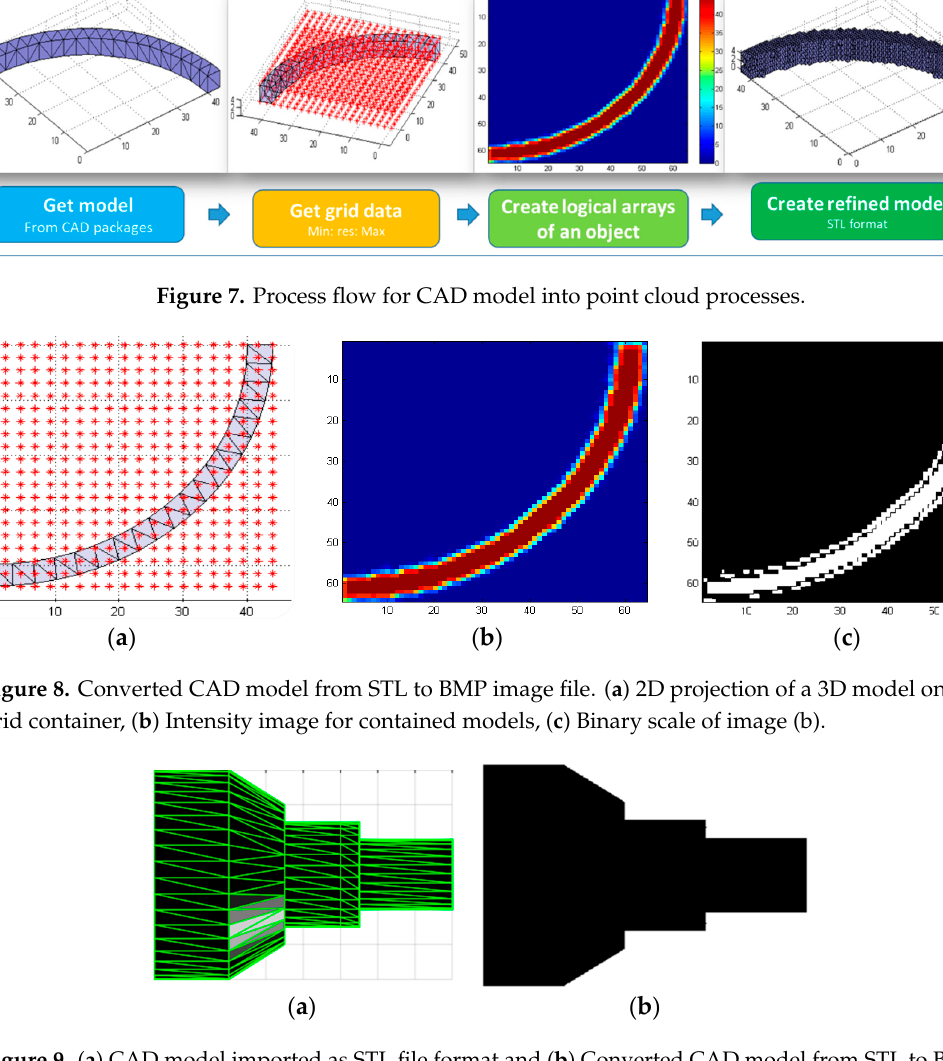
Figure 9. ( a ) CAD model imported as STL file format and ( b ) Converted CAD model from STL to BMP image file.